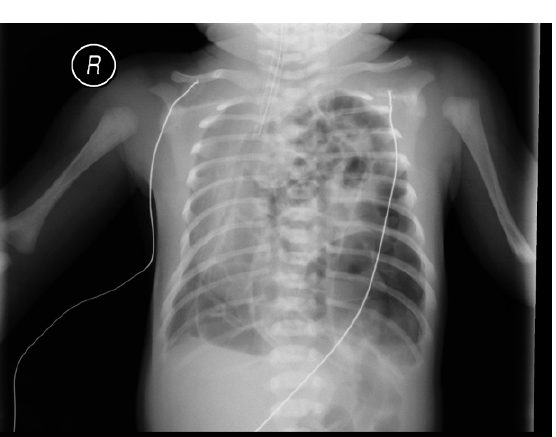
Figure 3. Renal ultrasonography indicates a 7.4 cm right kidney with normal parenchymal echogenicity in the patient at 8 months of age.